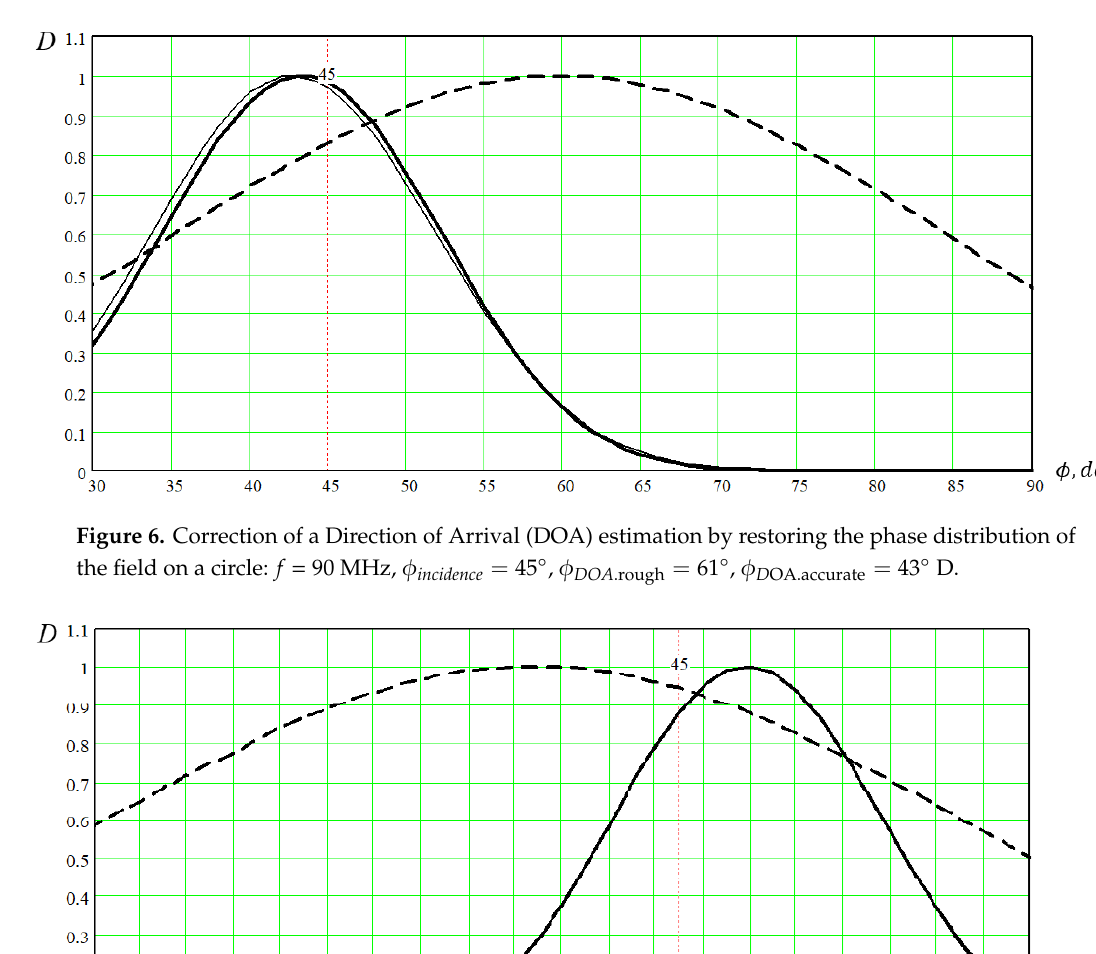
Figure 5. Phase distributions of E z -field on a circle with radius r = 1 m (antenna array radius R = 0.5 m) obtained by numerical simulation (circles) and approximation (solid lines) at frequency f = 140 MHz.